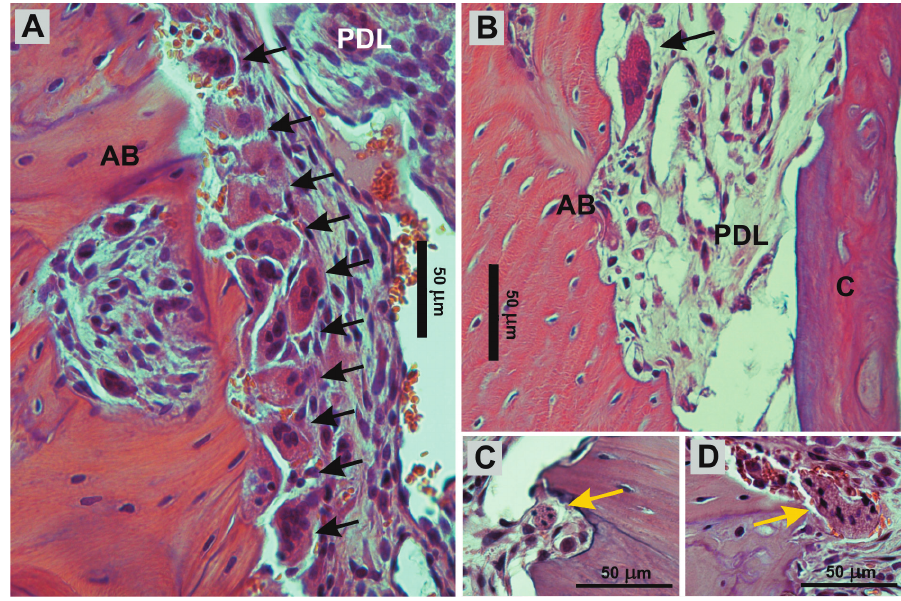
AB=alveolar bone; PDL=periodontal ligament; C=cementum; bars=50 Figure 5- Micrograph of the compression side of a right first molar from A: control and B: experimental group. The number of osteoclasts (black arrows) was significantly lower in the alendronate-treated rabbits. C, D: osteoclasts with nuclear condensation, a sign of apoptosis, were found (yellow arrows); (hematoxylin and eosin staining, 400x)